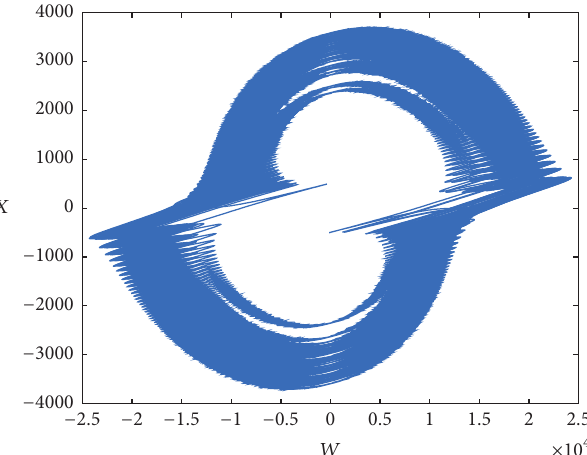
Figure 20: Bidimensional XW projection of the hyperchaotic attractor for {𝑎 = 38 and 𝑑 = 2} . Initial conditions: (−3203, −26967 , 32052, −5434) .